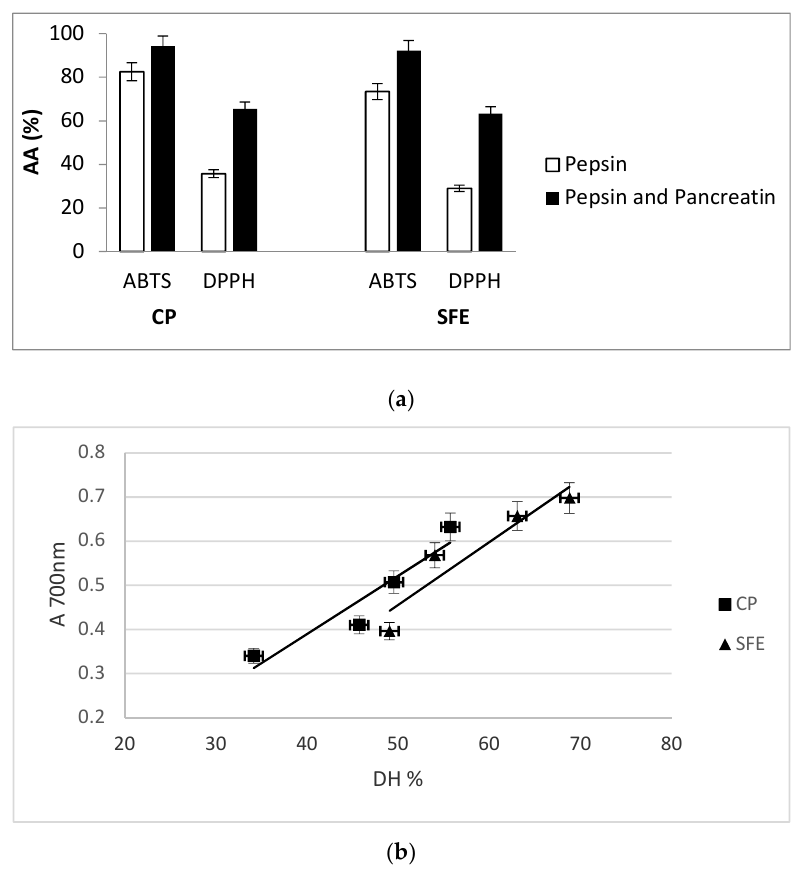
Figure 4. ( a) Comparison of antioxidant activities (AA) of hydrolysates obtained after in vitro digestion of apricot oil cake protein isolates derived by cold pressing (CP) and supercritical fluid extraction (SFE) measured as 2,2’-azino-bis (3-ethylbenzothiazoline-6-sulphonic acid) (ABTS) and 2,2-diphenyl-1-pikryl-hydrazyl (DPPH) radical scavenging activity. Values represent the mean ± standard deviation (SD) of n = 3 replicate analysis; ( b ) Reducing power of hydrolysates obtained after in vitro digestion of apricot oil cake protein isolates derived by cold pressing (CP) and supercritical fluid extraction (SFE) with different degrees of hydrolyses (DH). Values represent the mean ± standard deviation (SD) of n = 3 replicate analysis.